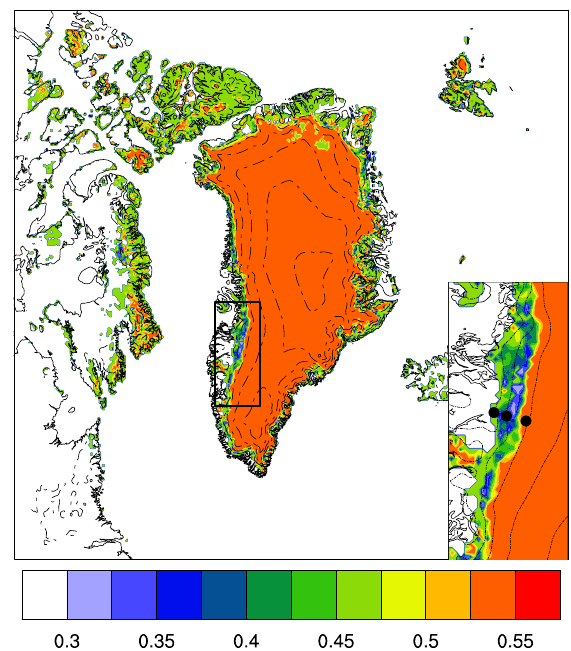
Fig. 1. Domain used in the RACMO2 simulations. The colors de- note background ice albedo as derived from MODIS satellite data, with a fixed value of 0.55 assumed for areas currently covered by a permanent snow cover. Contour lines are at a 500m surface eleva- tion intervals. The area of the K-transect with the locations of the three automatic weather stations (S5, S6 and S9 from west to east) is expanded in the